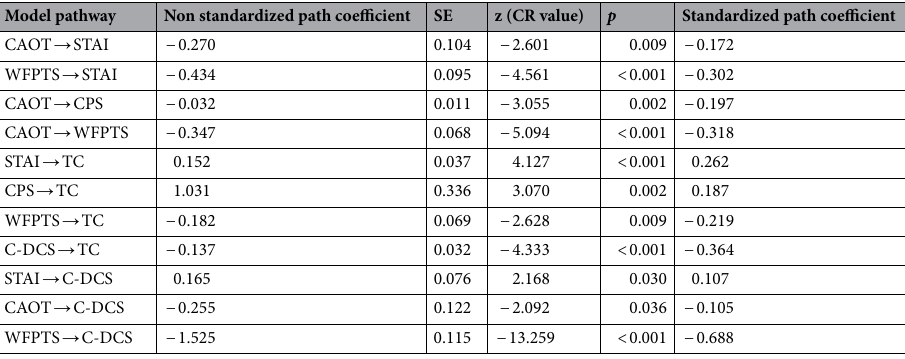
Table 6. The correlation among psychological states and decision-making characteristics (n = 231).